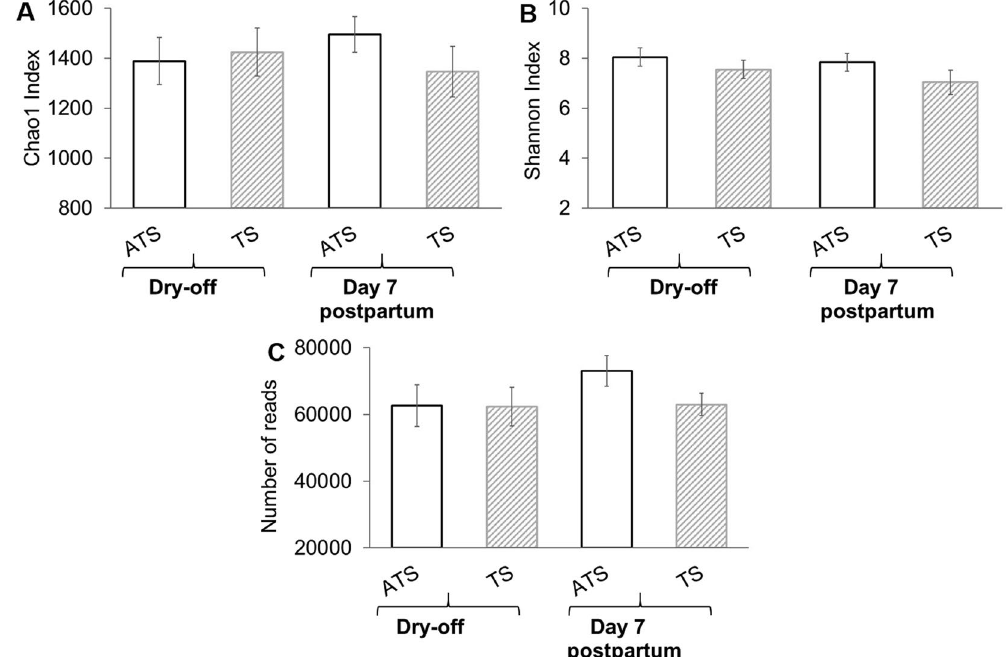
Figure 1. Bar graphs illustrating the Chao1 richness index ( A ), Shannon diversity index ( B ) and number of reads ( C ) for dry cow therapy with antibiotic (ceftiofur hydrochloride) and teat sealant (ATS) or just teat sealant (TS) at dry off and 7 d postpartum. Error bars correspond to standard error of the mean.